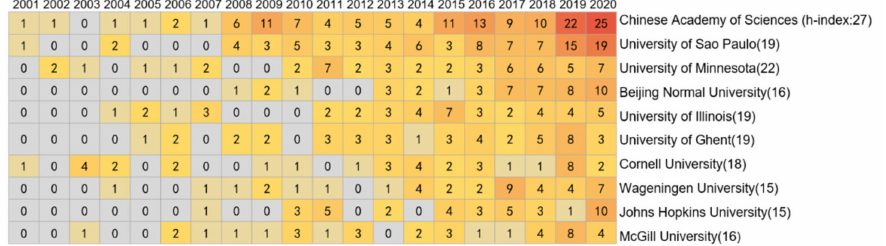
Figure 4. Performance of the top 10 most productive institutions.